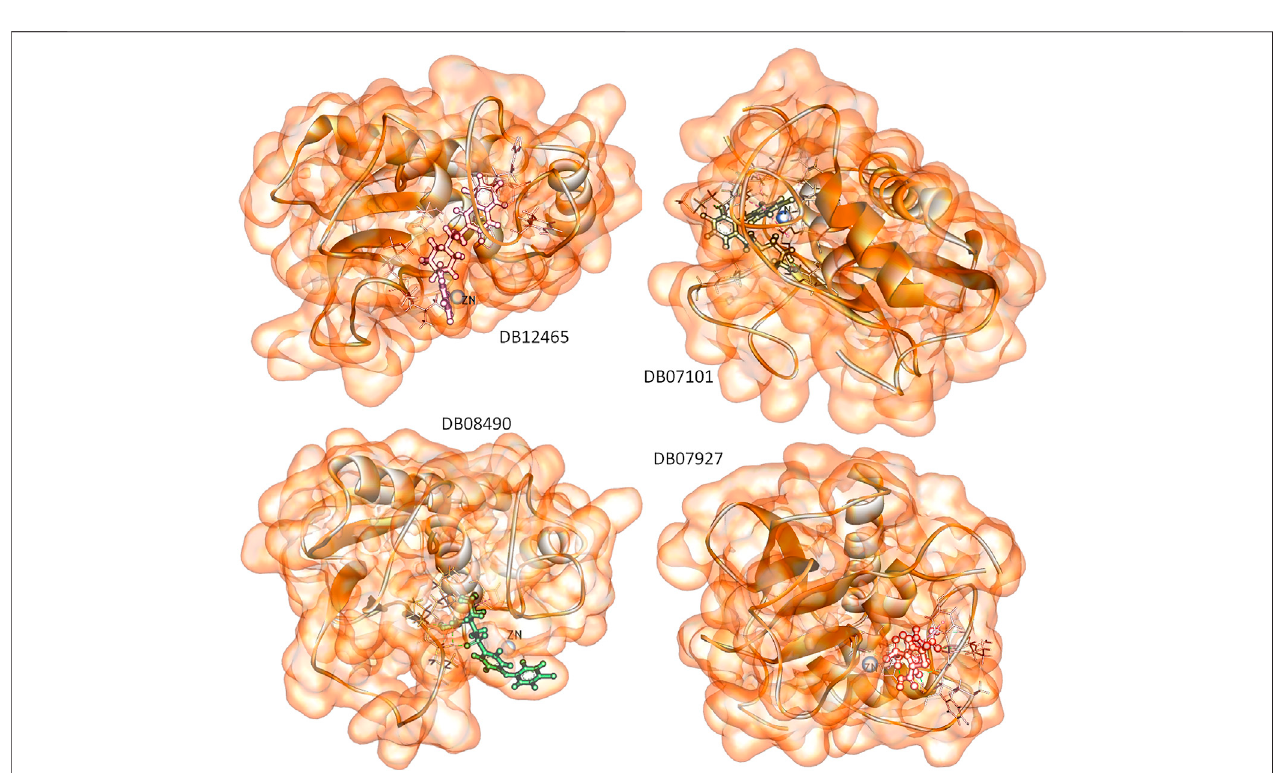
FIGURE 11 | Snapshots of selected four ligands over the course of 100 ns MD